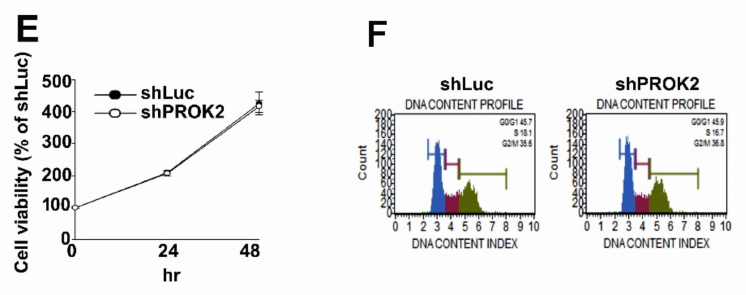
Figure 2. E ff ect of knockdown PROK2 on cell viability and cell cycle in human cervical cancer HeLa cells. ( A , B ) Immunoblotting and RT-qPCR analysis of PROK2 protein and mRNA expression in three cervical cancer cell lines (C33A, HeLa and SiHa). β -actin as a protein loading control, GAPDH as a mRNA loading control. ( C,D ) The protein and mRNA expression of PROK2 in shLuc- or shPROK2-HeLa cells. ( E ) Cell viability of shLuc- or shPROK2-HeLa cells was measured by cell viability assay at 24 h and 48 h after seeding. ( F ) Cell cycle distribution of shLuc- or shPROK2-HeLa cells were measured by flow cytometry.